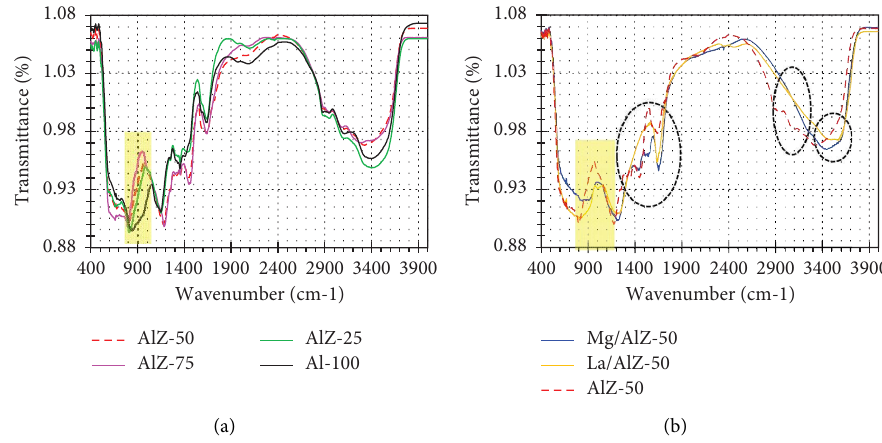
Figure 8: Oxide catalysts’ surface functional group and structural parameters.